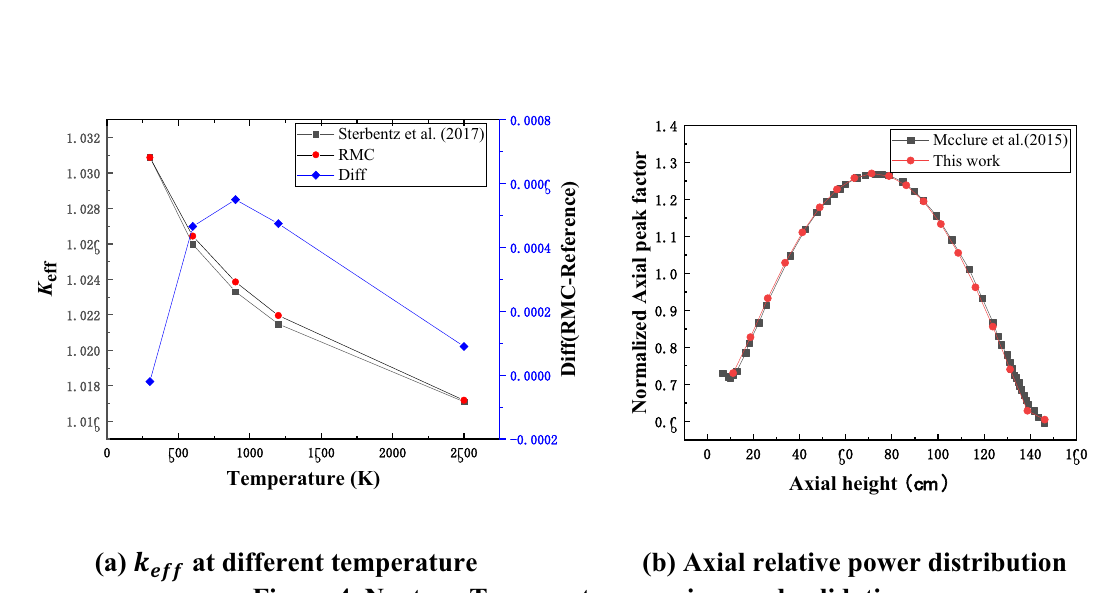
(b) Axial relative power distribution Figure 4. Neutron Transport comparison and validation